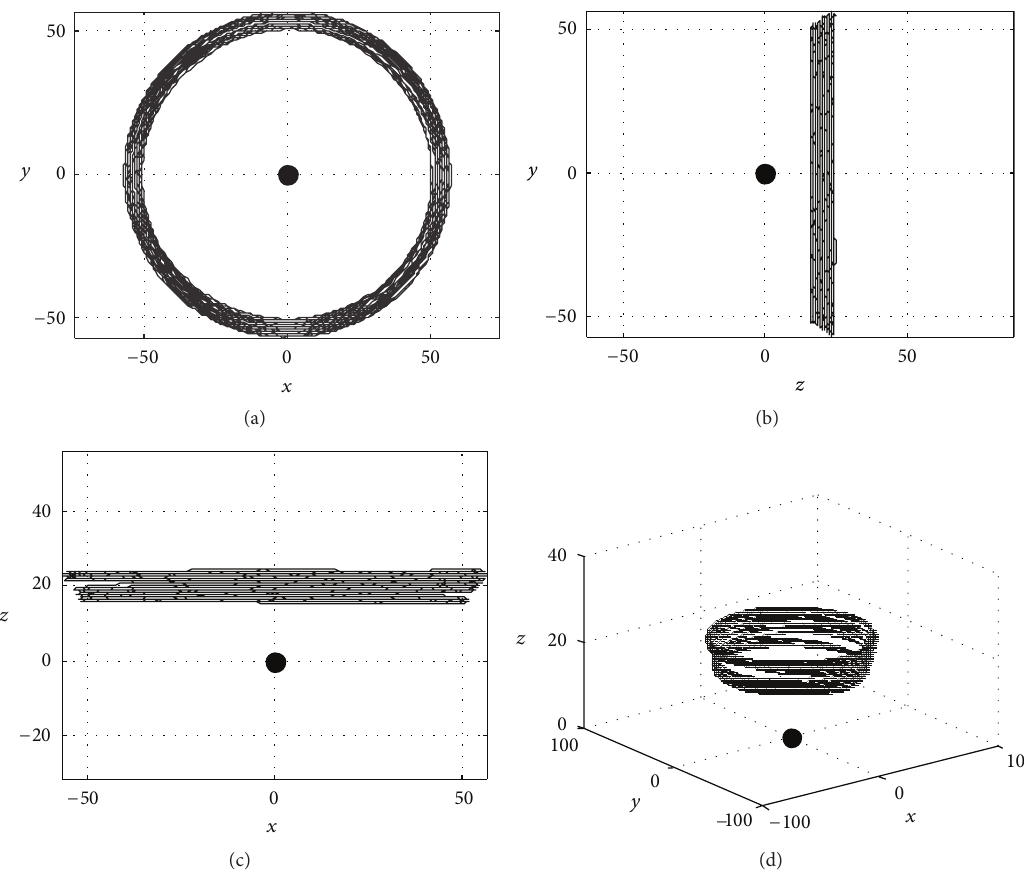
Figure 10: Quasiperiodic orbits by the controller in the 3D physical space: 𝐺 1 = 0, 𝐺 2 = 0, 𝐺 3 = 0.3, Δ = 0.0005 .